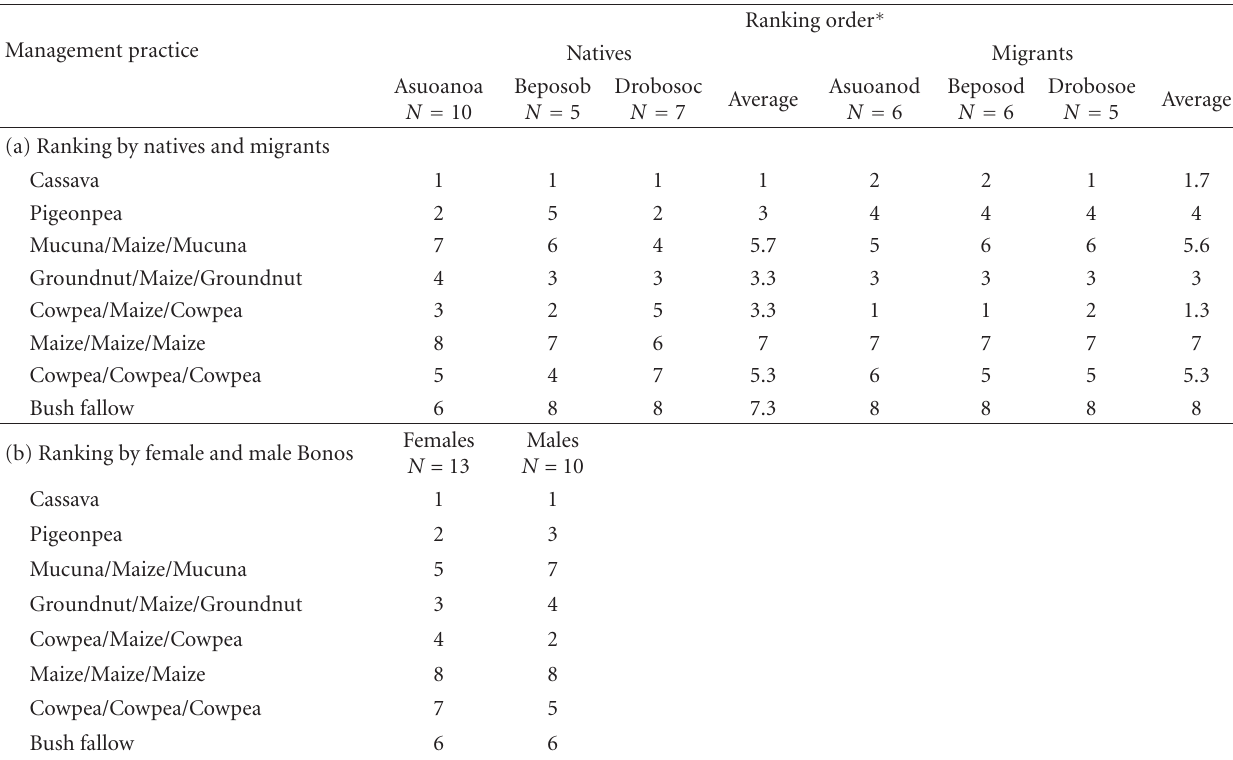
Table 5: Preferential ranking of di ff erent soil fertility management practices by native and migrant farmers in Wenchi. Management